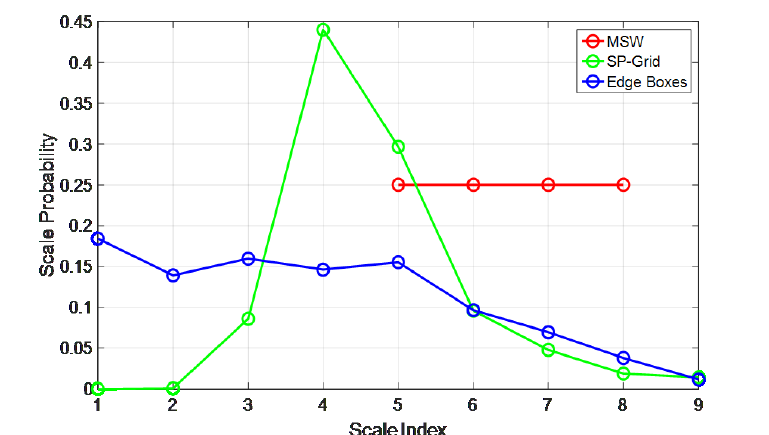
Figure 5. Landmark distribution of MSW, SP-Grid and Edge Boxes on all four datasets. Edge Boxes tends to produce a high number of small landmarks and the scale distribution is non-uniform. SP-Grid produces a peaked landmark scale distribution at close to scale index 4. Scale distribution of our MSW method is